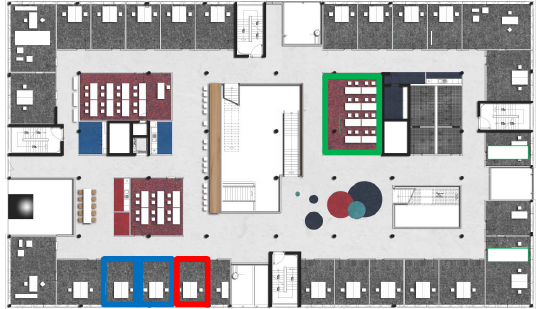
Figure 6. Rooms for field test validation, marked with a blue